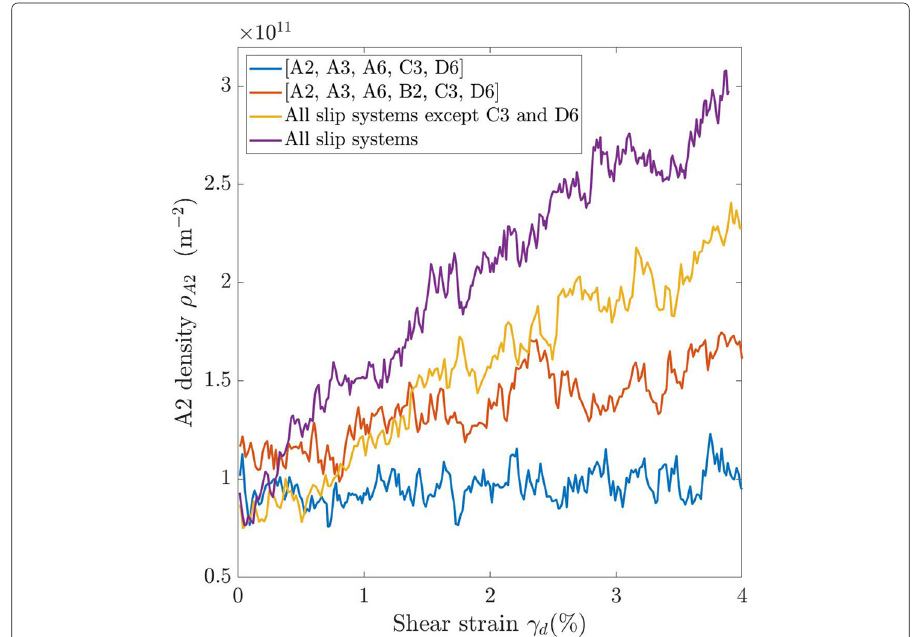
Fig. 12 Evolution of ρ i for i = A2 from four DDD simulation along the [4910] loading orientation with